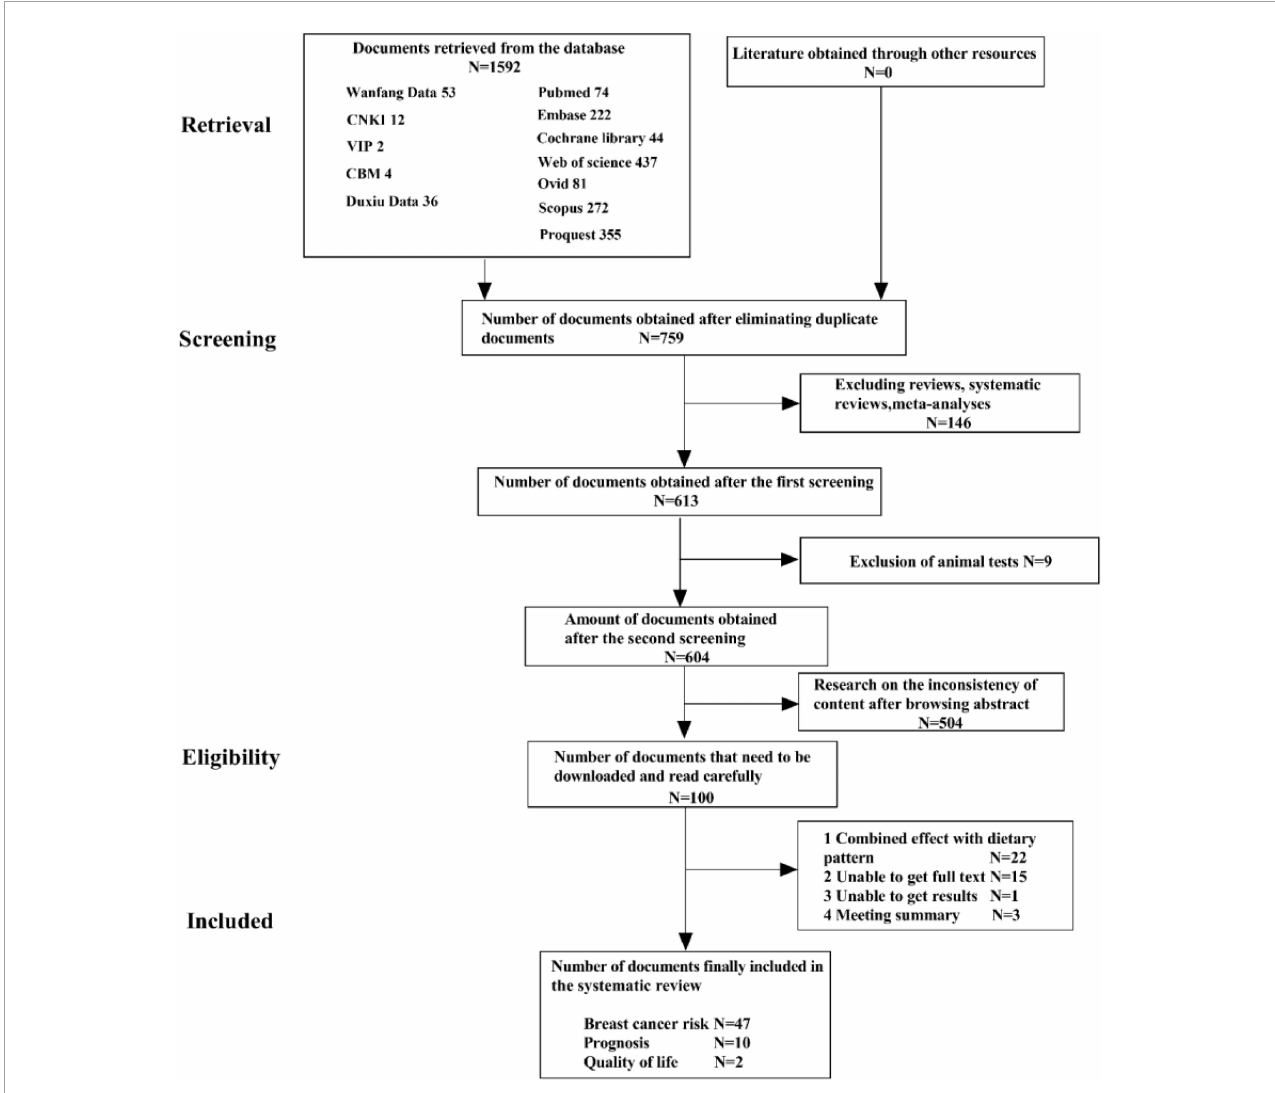
FIGURE1 Document screening flow